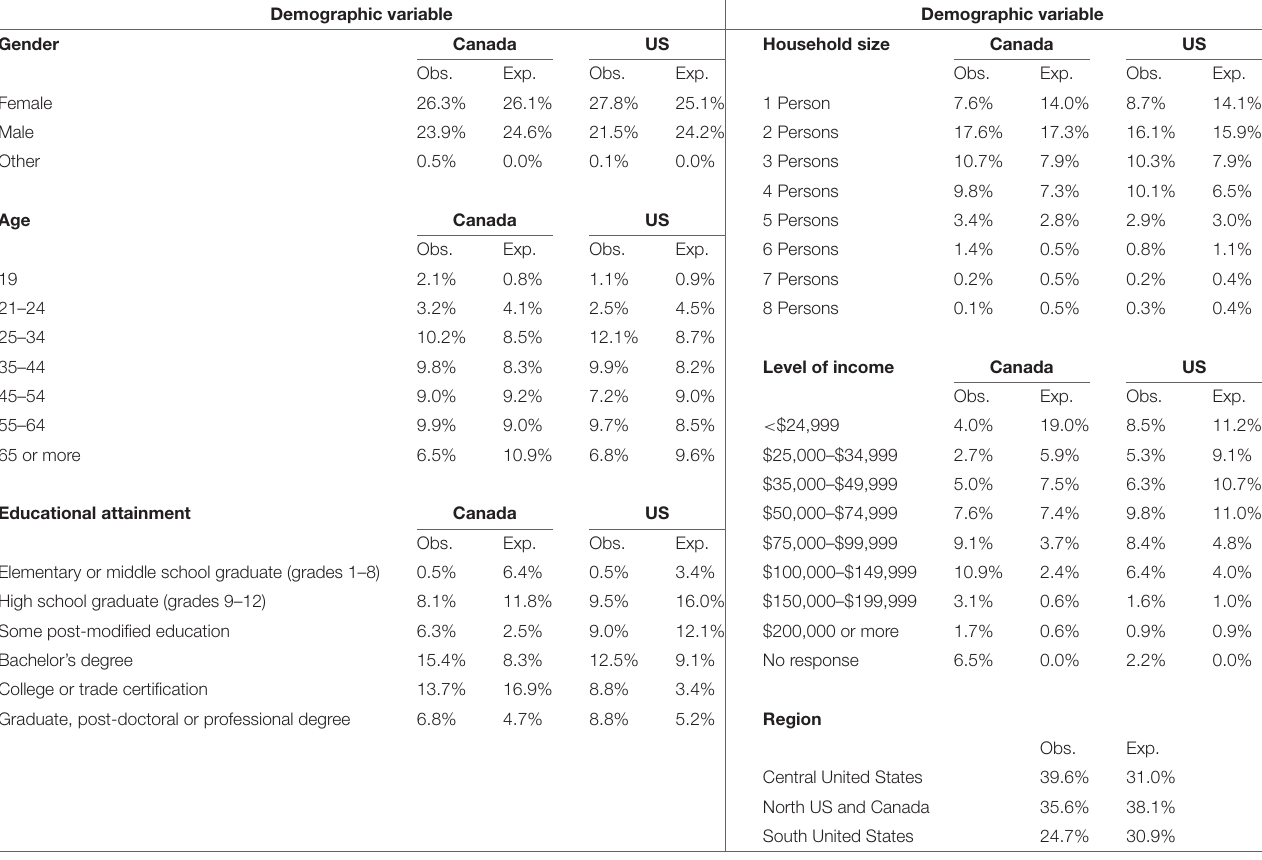
TABLE 1 | Demographics from the main sample of urban residents ( n =